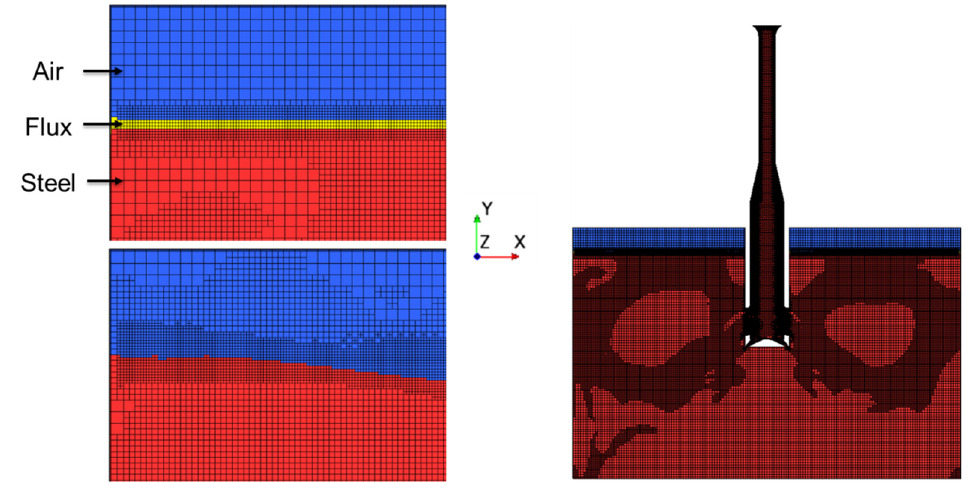
Figure 3. AMR simulation mesh.